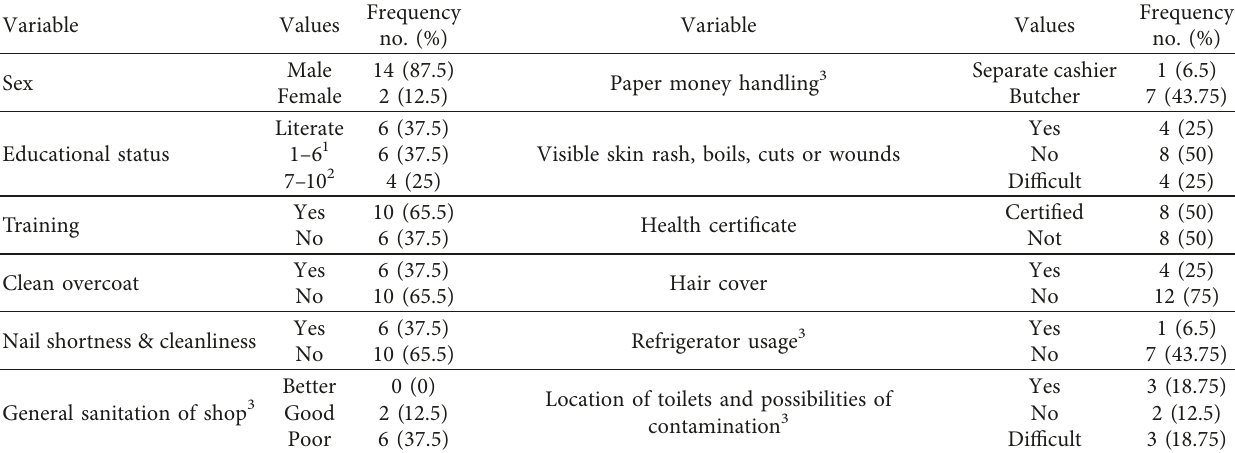
Table 1: Sex, educational status, and survey on knowledge of butchers on hygienic practices in Gullele Subcity. Variable